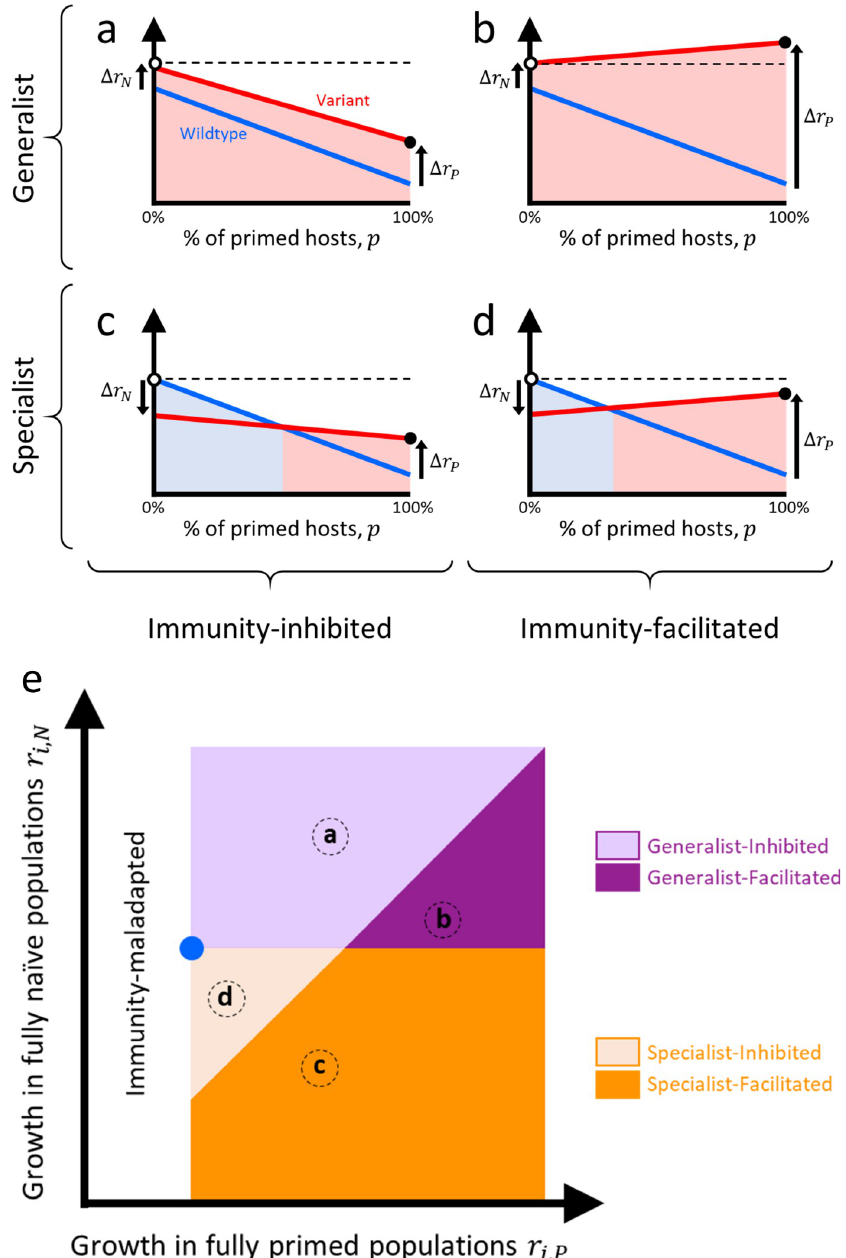
Fig 2. Four types of immunity-adapted variants. Solid lines depict the growth rate of the population of infected individuals for the wild type (blue) and for a variant (red) as a function of the fraction of the population that has been primed against infection by vaccination, previous infection, or both. Priming decreases the growth rate of the wild type ( r N > r P ). Quantities Δ r N and Δ r P are the differences in growth rate between the variant and the wild type in na ï ve and primed hosts, respectively. Colored shading indicates which type prevails evolutionarily: the wild type (light blue shading) or the variant (light red shading). Panels ( a ) and ( b ) show generalists; the variant is also better adapted to naive hosts ( Δ r > 0). Generalist variants will outcompete the wild type even in the absence of priming. Panels ( c ) and N ( d ) show specialists; the variant is maladapted to na ï ve hosts ( Δ r N < 0). Specialist variants will outcompete the wild type only above a critical threshold. Panels ( a ) and ( c ) show immunity-inhibited variants; the growth rate of the variant decreases with increasing fractions of primed hosts. As a result, the growth rate of infections after adaptation (i.e., after fixation of the fittest type) in a fully primed population (black dot) is always lower than that in a fully na ï ve population (white dot and dashed line). Panels ( b ) and ( d ) are immunity-facilitated variants; the growth rate of the variant increases with increasing fractions of primed hosts. As a result, the growth rate of infections after adaptation in a fully